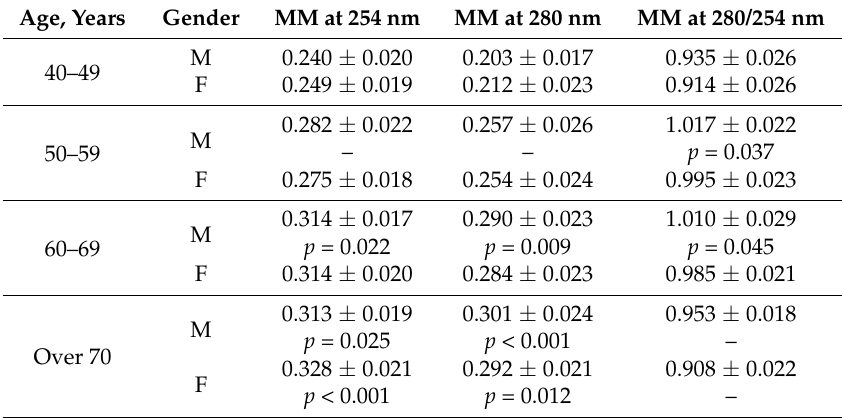
Table 2. MM levels depending on gender and age in patients with lung